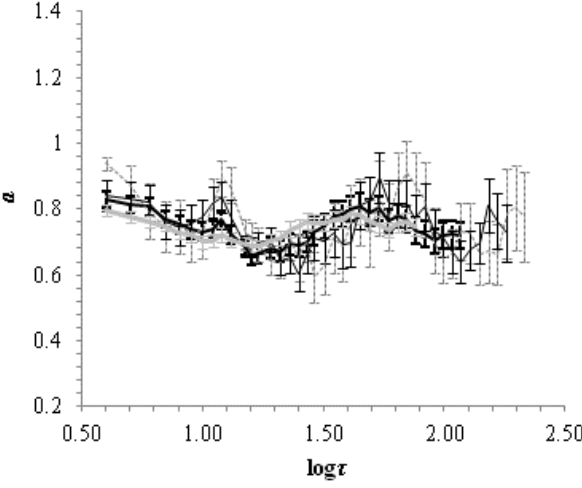
Fig. 7. Local slopes of the log F d (τ) vs. log τ (10-base logarithms) calculated within a window of 8 points (dashed grey line), of 10 points (solid thin black line), of 15 points (solid bold black line) and of 20 points (solid bold grey line) for the detrended time series of the mean monthly global LSAT anomalies. The grey and black error bars indicate the corresponding 1.96 · s a – intervals of the slopes over all the considered scales.